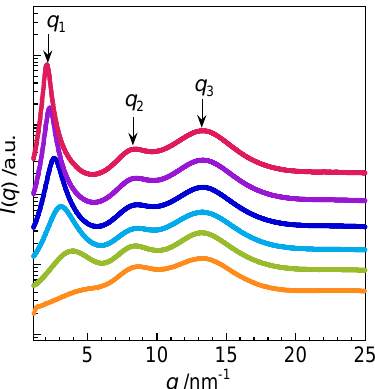
Figure 3. WAXS profiles of 2C n (2-O-2) NTf 2 at 25 ◦ C: n = 4 (orange • ), n = 6 (yellow green • ), n = 8